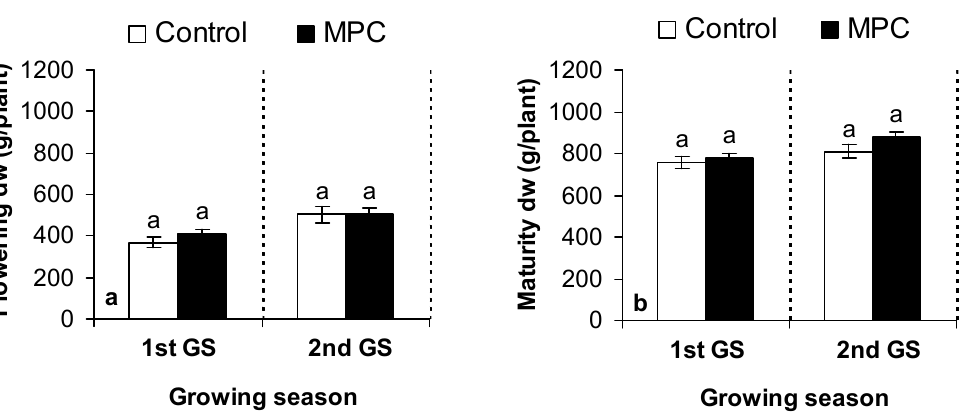
Figure 3. Aboveground dry weight (dw) of sunflower plants at flowering ( a ) and at maturity ( b ) as influenced by foliar applications of MPC (37.5 + 37.5 g ha − 1 in the 1st growing season (GS) and 37.5 + 37.5 g + 37.5 g ha − 1 in the 2nd (GS). Different letters within each GS show statistically significant differences at p < 0.05 and vertical bars denote standard errors of means ( n = 12). MPC, mepiquat chloride.